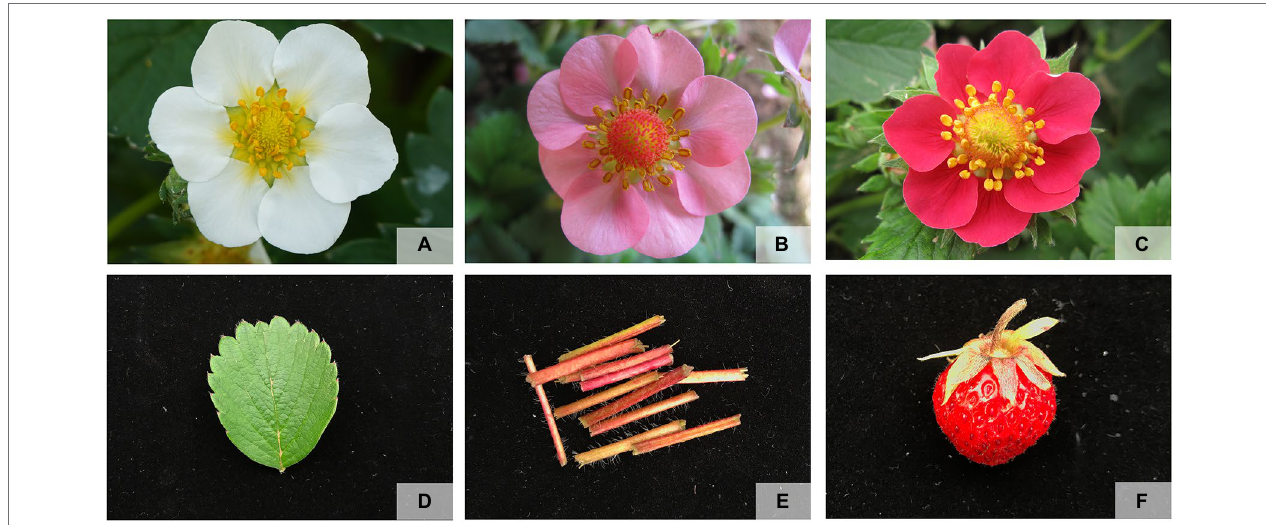
FIGURE 1 | The materials used to detect the R2R3-FaMYB gene expression. (A) Fresh petals with white color at the full-bloom stage, (B) fresh petals with pink color at the full-bloom stage, (C) fresh petals with red color at the full-bloom stage, (D) leaf, (E) petiole, (F)